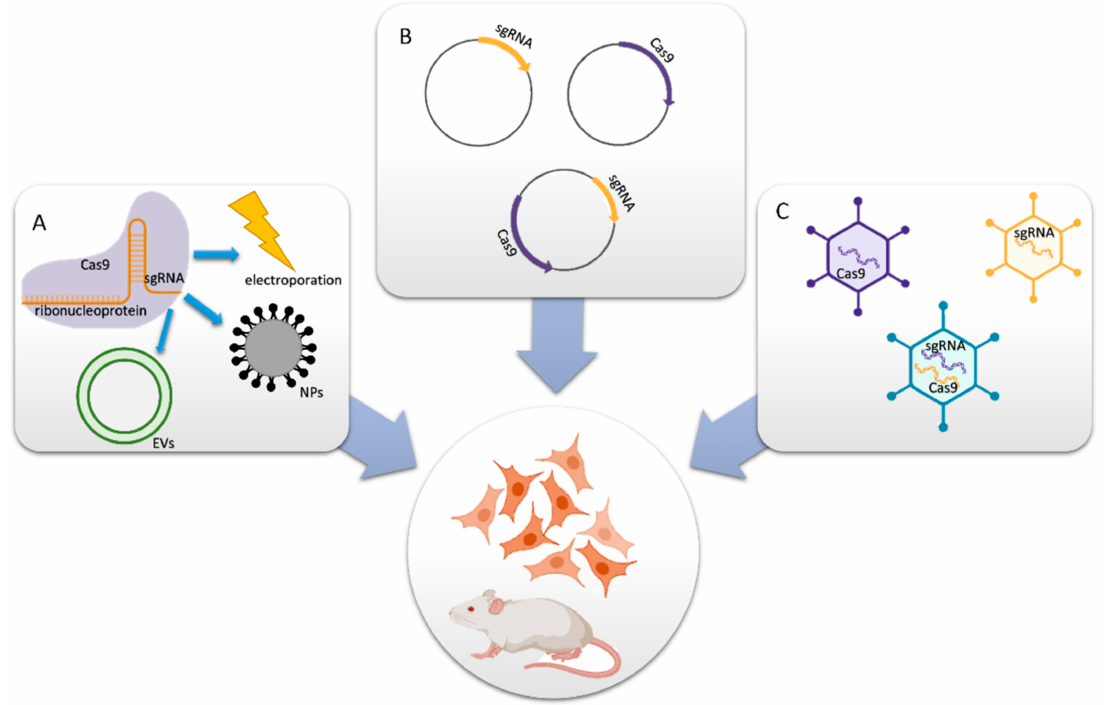
Figure 1. Delivery methods for CRISPR-Cas9 components. ( A ) Cas9 protein and sgRNA form an RNP complex for packaging purposes. ( B ) Cas9- and/or sgRNA-expressing plasmids are transferred into cells. ( C ) In vitro or in vivo viral vectors encoding Cas9 and/or sgRNA convey the mechanisms (reprinted with permission from [34]).